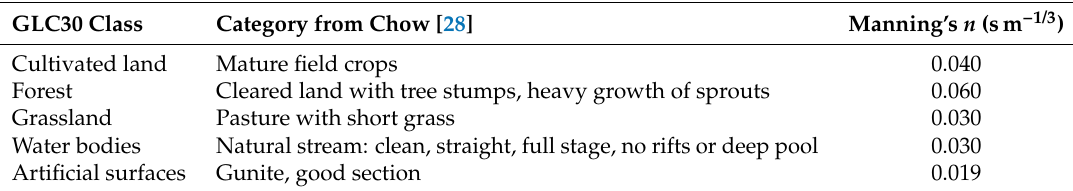
Figure 4. Land cover classes from Global Land Cover in the study area. Table 4. Relation between land cover classes and Manning’s n